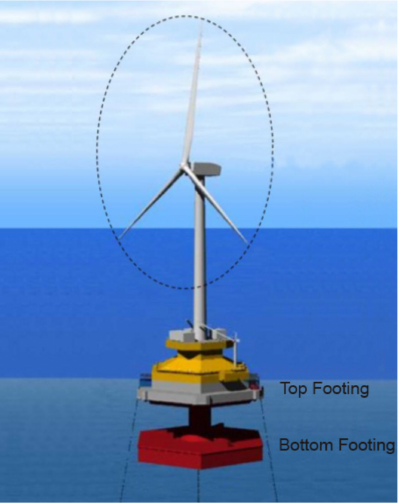
Figure 1. The conceptual idea of the Advanced Spar FOWT type with